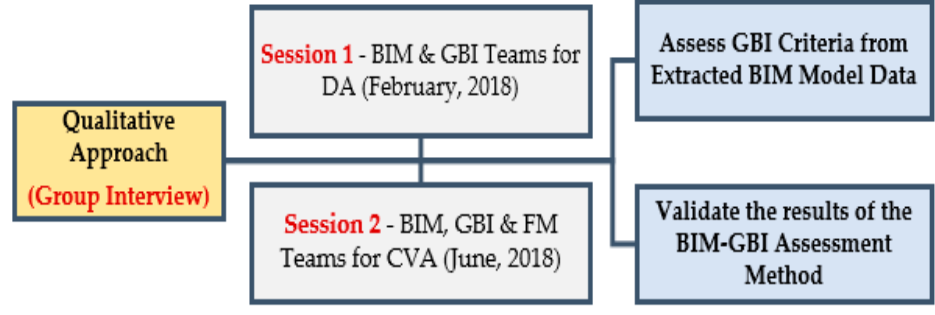
Figure 2. Research framework.